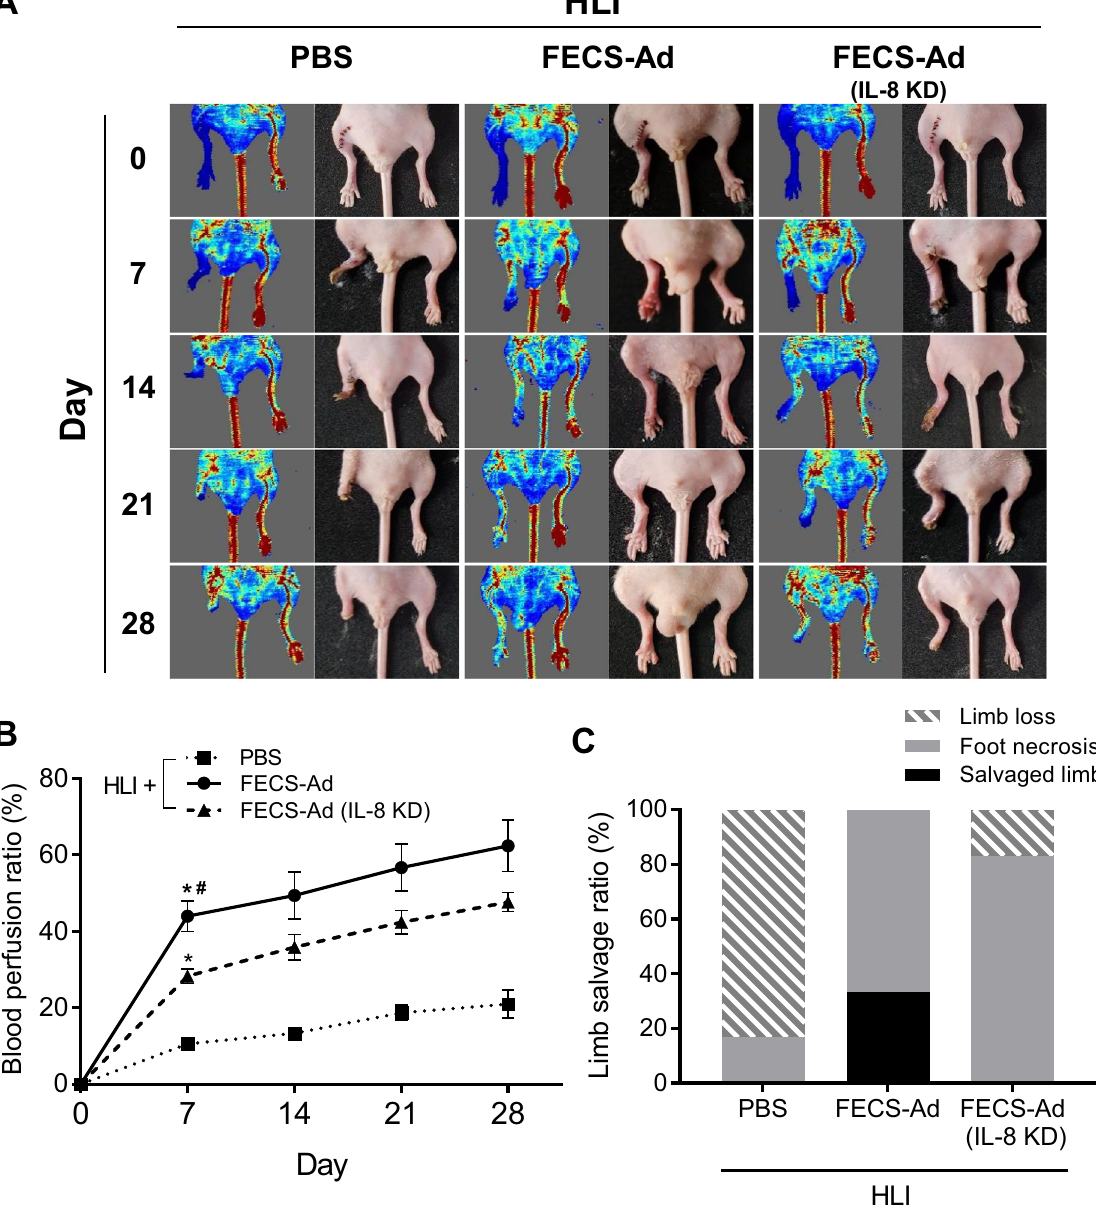
Fig. 7 Roles of IL-8 in the therapeutic potential of FECS-Ad in mouse hindlimb ischemia. One day after HLI induction, mice were i.m. injected with PBS, FECS-Ad, or IL-8-silenced FECS-Ad. Morphometric analysis and blood perfusion was assessed at 7, 14, 21, and 28 days post- surgery. A Representative images of hindlimb morphology and blood perfusion of each group. n = 6 per group. B Blood perfusion ratio (percentage of normal limb) of ischemic limbs quantitated by laser Doppler imaging. Asterisk denotes signi fi cant difference compared to PBS group ( p < 0.0001) and hash denotes signi fi cant difference compared to FECS-Ad (IL-8 KD) group ( p < 0.0001) (two-way ANOVA). n = 6 per group. C Physiological status of ischemic limbs assessed at 28 days post-surgery. n = 6 per group. All data are presented as mean ± antigen (HNA). FECS-Ad injected into the thigh muscle retained not only in the injected area, but also in the distal region of the ischemic limb (Fig. 8B, E). We further analyzed the density of their spherical shape at day 3 (Supplementary Fig. 6E). HNA- microvessels and arterioles by immuno fl uorescence using an α - positive cells were observed at day 7 in both the FECS-Ad and IL- SMA antibody. Similar observations were made with the α -SMA- 8-silenced FECS-Ad groups (Fig. 8A), and their numbers gradually positive cell population, that is, a progressive increase in blood decreased until 28 days post-surgery. HNA-positive cell popula- vessel density was observed in the FECS-Ad-injected group tions between the two groups did not differ signi fi cantly (Fig. compared to the PBS-treated group. IL-8 silencing in FECS-Ad 8C). HNA-positive cells were not observed in TA muscles in signi fi cantly lowered the α -SMA-positive cell ratio in both thigh any of the groups, indicating that hASCs implanted in the form of and TA muscles (Supplementary Fig. 6A – D). Next, the distribution FECS-Ad only existed in the local area of the injection site of hASCs from FECS-Ad after transplantation to the ischemic (Fig. 8B). muscle was assessed by immunostaining for human nuclear